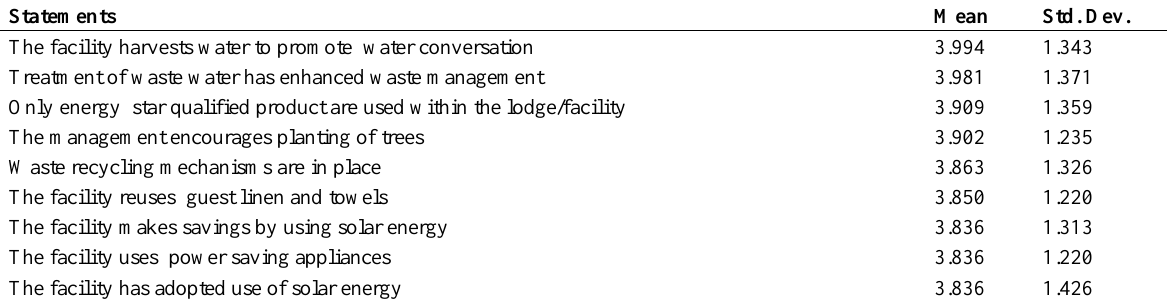
Table 3: Green Practices in Lodges and Tented